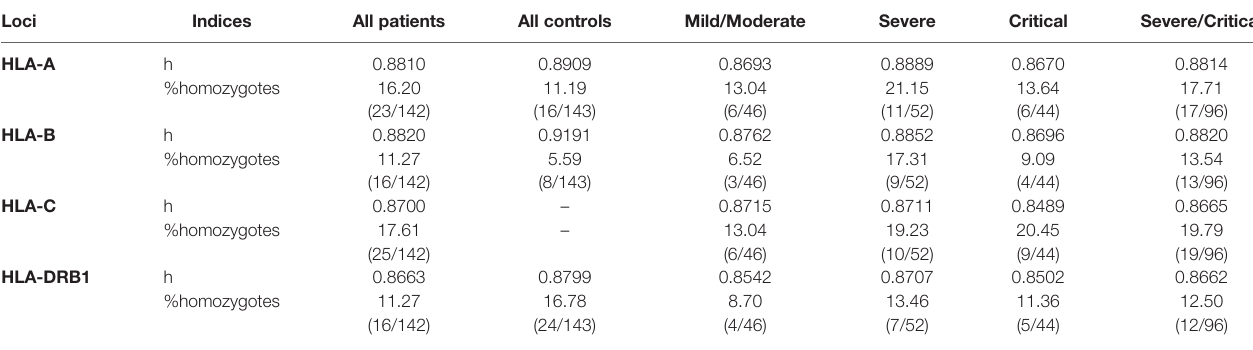
TABLE 1 | Heterozygosity and proportion of homozygotes at each HLA locus computed for each group and subgroup. Loci Indices All patients All controls